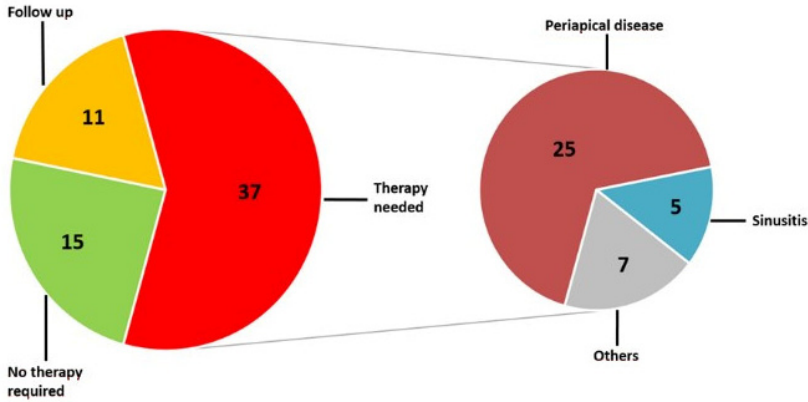
Figure 4. Pie chart of all incidental findings among those patients whose therapeutic management had to be adjusted due to the findings in CBCT and DVT. Presented is a breakdown of the red-rated incidental findings to their etiologic origin.